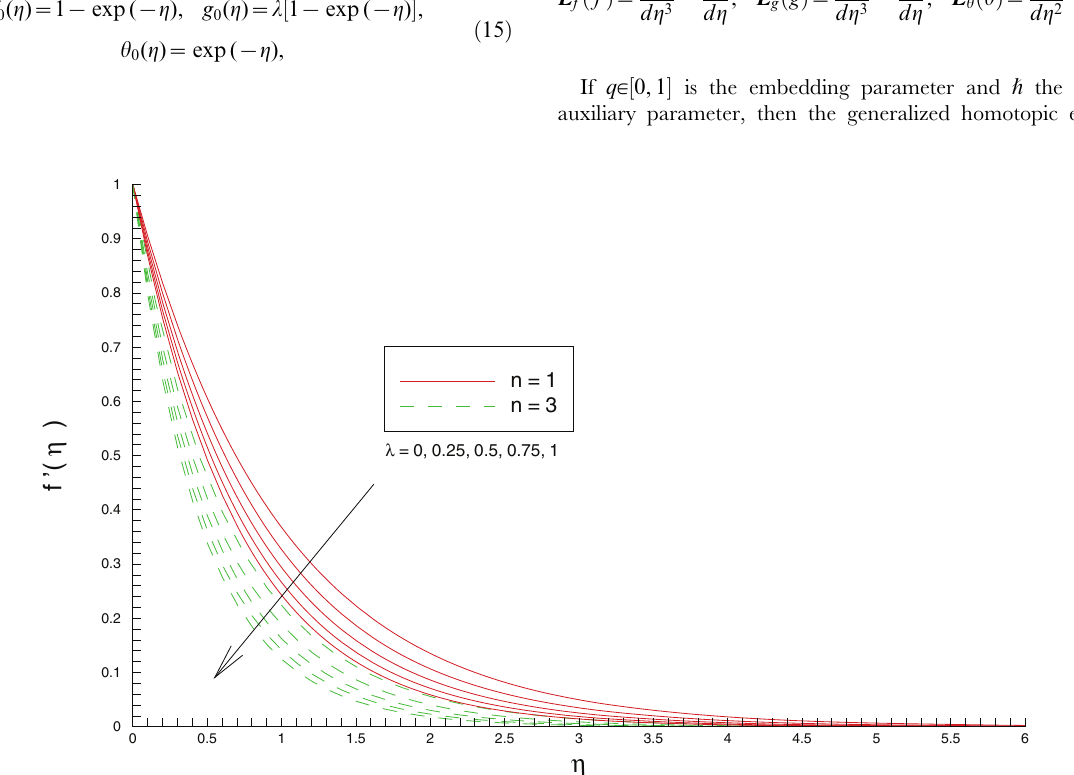
Figure 3. Influence of stretching rates ratio l on the x { component of velocity f 0 :